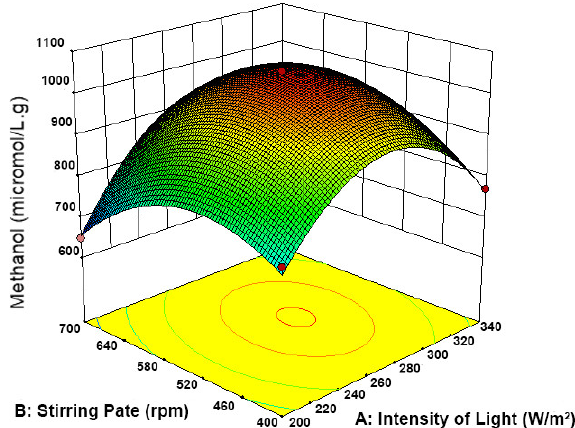
Figure 10. Effect of intensity of light and stirring rate on methanol yield.